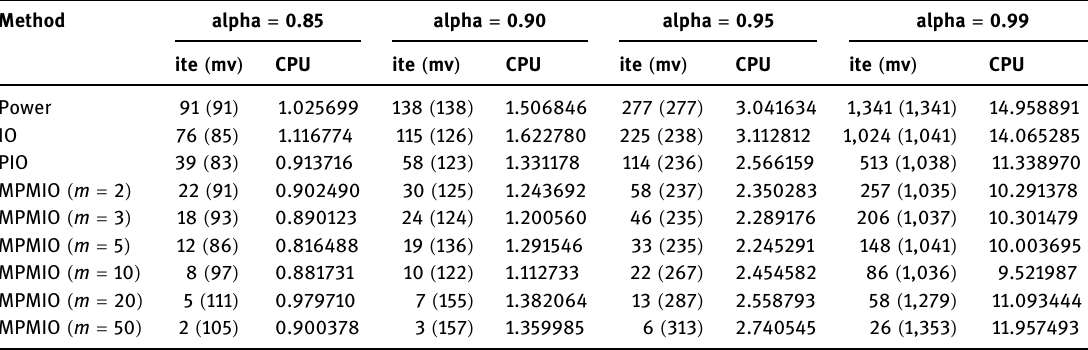
Table 3: Numerical results for Example 2 with β 0.5